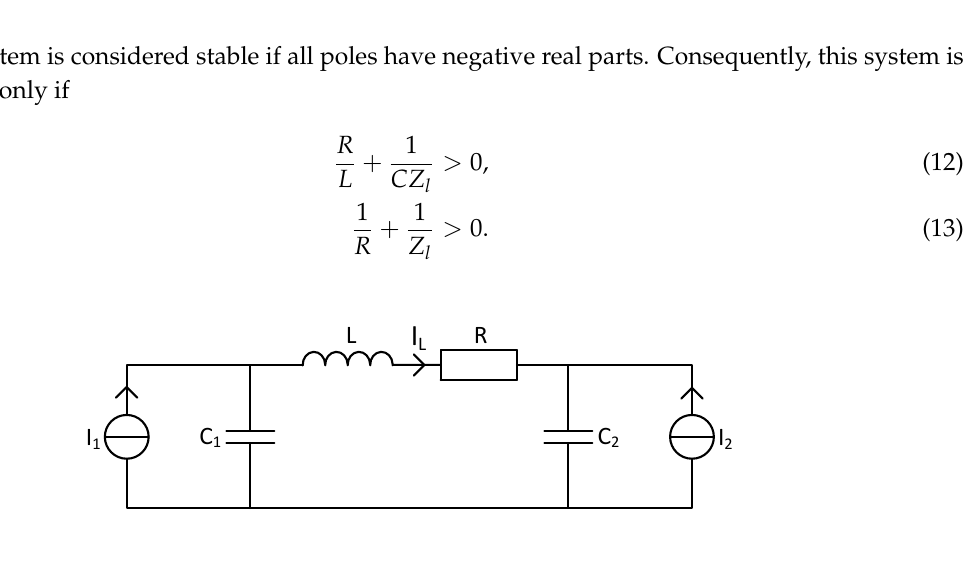
Figure 4. Simple DC distribution grid containing a constant power load and a droop controlled source connected via a distribution